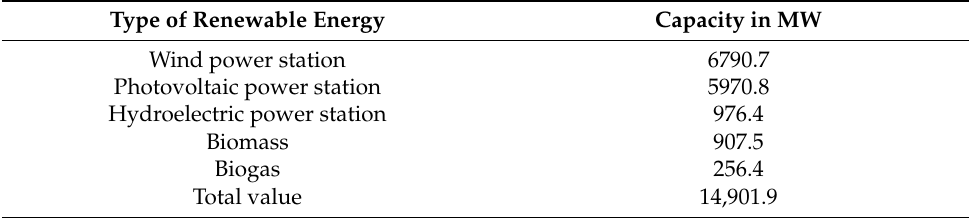
Table 3. The production capacity of renewable energy sources in Poland—situation as of 30 August